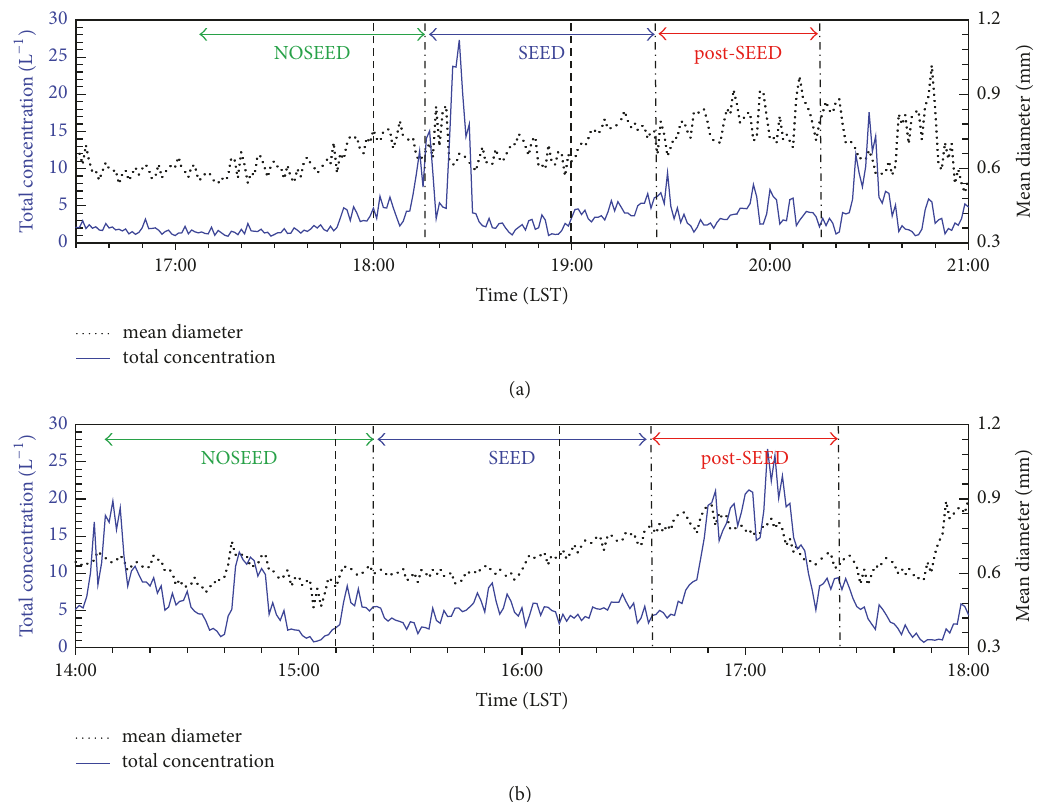
Figure 11: Time series of snow size distribution obtained from the PARSIVEL at YP for (a) EXP2 and (b) EXP4. The dotted and solid lines indicate the mean diameter and total particle number concentrations of snow particles, respectively.